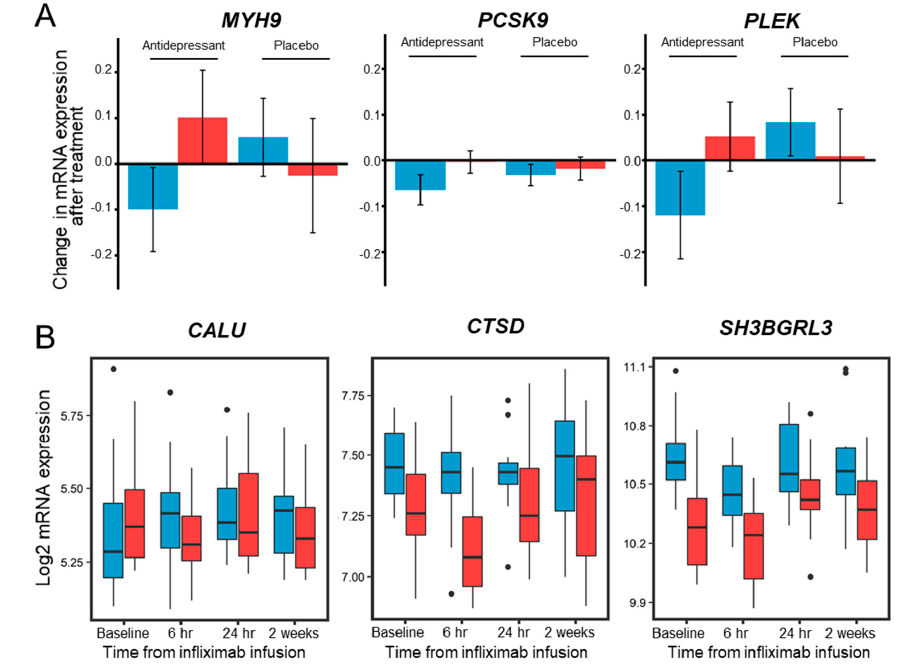
Figure 3. External validation of LMM-significant 37 proteins in two public GEO datasets (GSE146446 and GSE45468). ( A ) In the GSE146446 dataset, the quantitative mRNA expression changes in three genes, MYH9 , PCSK9 , and PLEK , before and after 8 weeks of taking the antidepressant and placebo in responders (blue color) and non-responders (red color). Error bars represent standard error of the mean. ( B ) In the GSE45468 dataset, the mRNA expression level of patients for three genes, CALU , CTSD and SH3BGRL3 , before infliximab infusion and after 6 h, 24 h, and 2 weeks is shown in box plots. Responders are shown in blue color and non-responders are shown in red